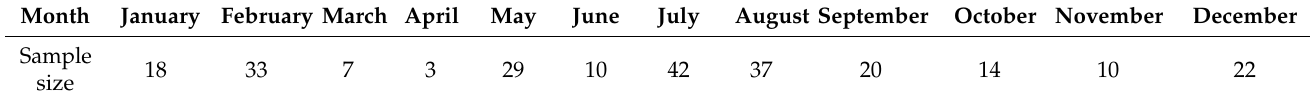
Table 1. Monthly sample size of Narcine entemedor specimens analyzed in the present study.